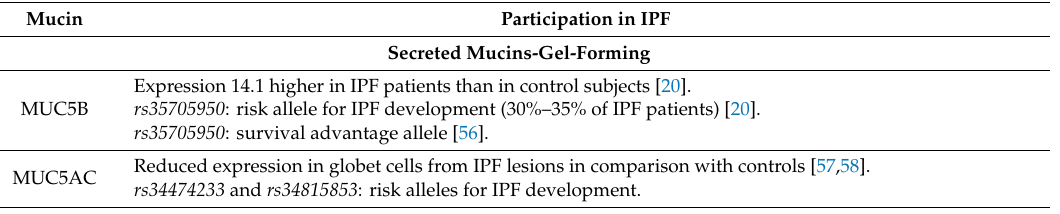
Table 3. Summarizes the main roles of the major lung mucins in